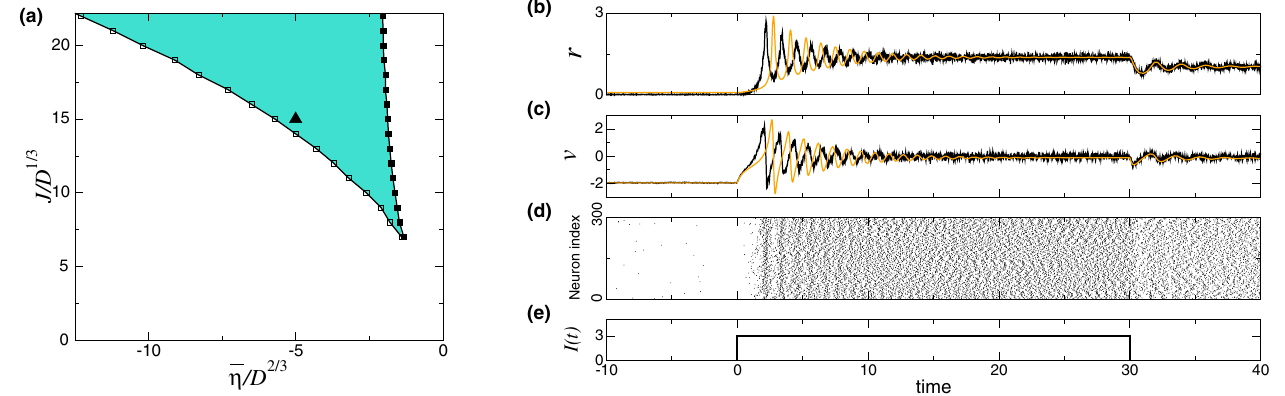
FIG. 8. Numerically obtained phase diagram (a) and time series (b) – (d) for a network of identical QIF neurons driven by independent white noise terms. The square symbols in (a) represent the boundaries that enclose the region of bistability between a high- and a low- activity state. The boundaries have been obtained using a network of 10 4 neurons, and by numerical continuation of a low-activity solution (filled squares) and a high-activity solution (empty squares). Specifically, using a noise intensity D ¼ 1 and a particular value of J , the system is initialized either at ¯ η ¼ − 5 or at ¯ η ¼ 0 and, after t ¼ 10 time units, parameter ¯ η is decreased or increased an amount 0.025 or 0.1, respectively. This continuation is made until the relative change of two successive values of the averaged firing rate (time averaged over the last time unit for each parameter value) is larger than 50%. Other parameters for the numerical simulations are the same as in all other figures, and are described in Appendix A. The triangle symbol indicates the parameter value, ð ¯ η =D 2 = 3 ; J=D 1 = 3 Þ ¼ ð − 5 ; 15 Þ , corresponding to the numerical simulations shown in black in the right-hand panels — for the simulations. we use D ¼ 1 . To facilitate the comparison with the FREs (12), the orange curves show the time series of the FREs, using the same parameters ð ¯ η ; J Þ ¼ ð − 5 ; 15 Þ , but with Δ ¼ 1